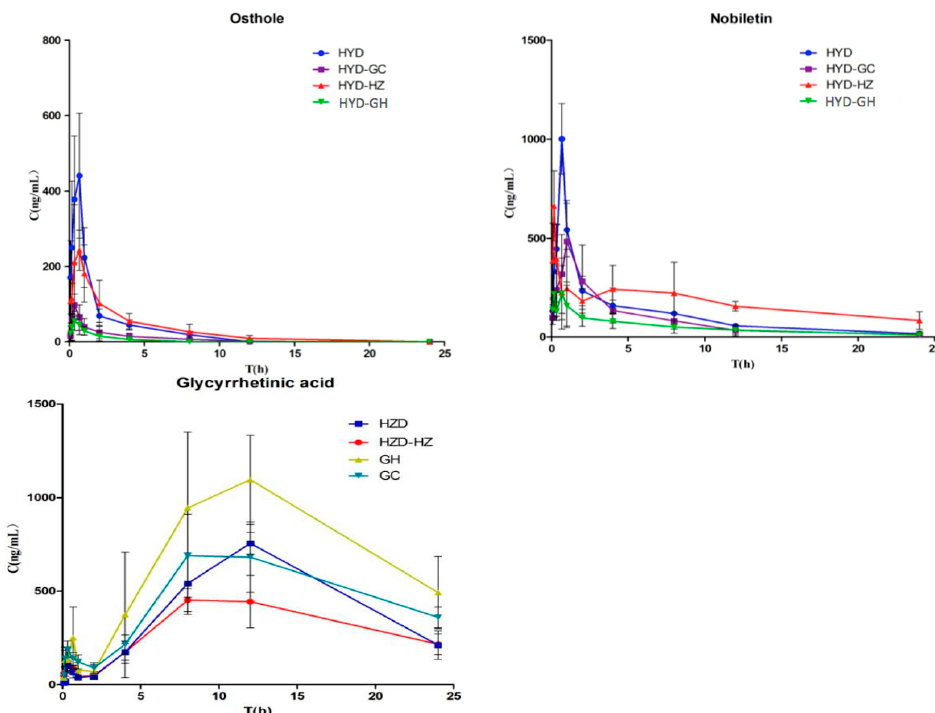
Figure 3. Mean plasma concentration–time curves of eleven compounds in the rat model of hypothyroidism ( n = 6).